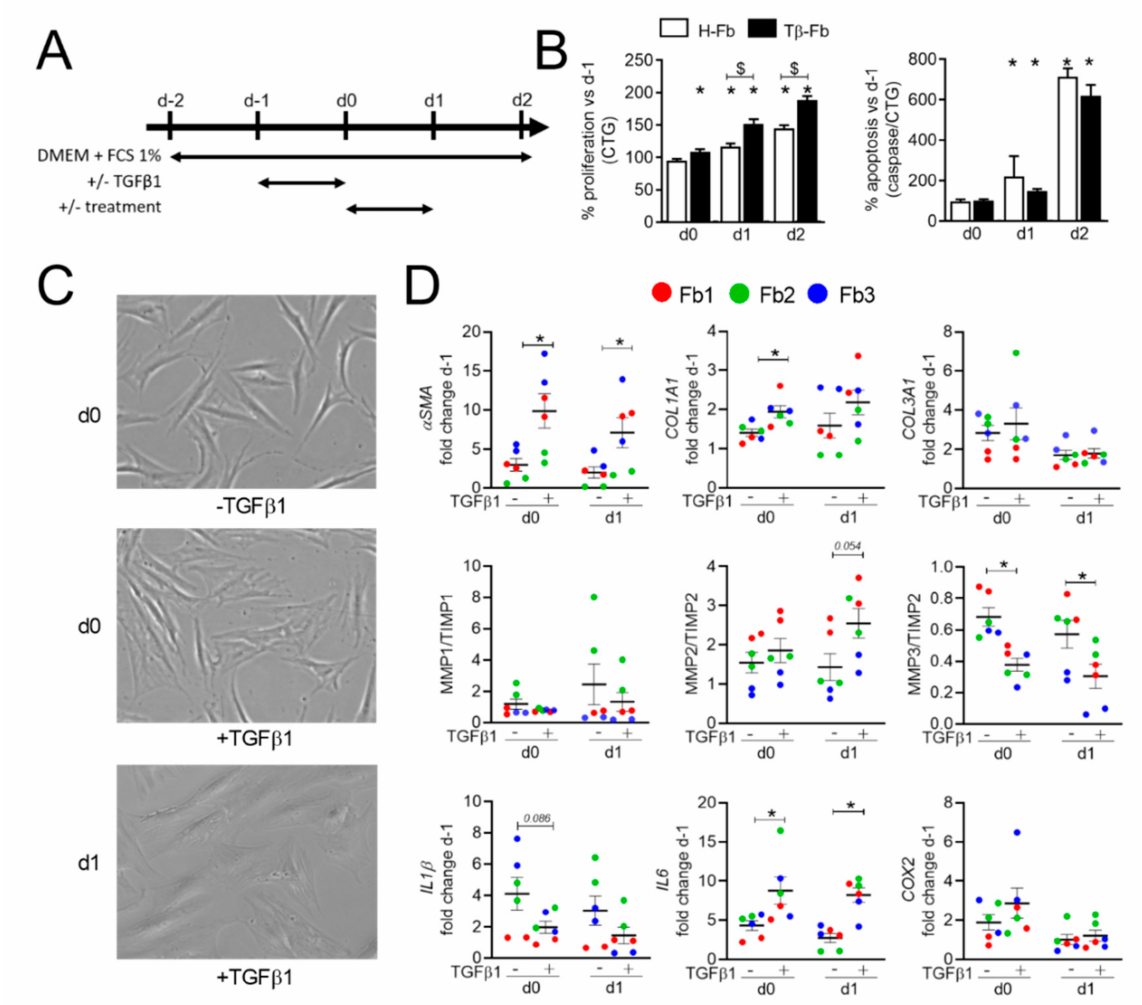
Figure 1. In vitro model of Transforming Growth Factor β 1 (TGF β 1)-stimulated fibroblasts. ( A ) Experimental scheme. Dermal fibroblasts from healthy donors (H-Fb) were starved in a DMEM medium containing 1% FCS (day-2) for 24 h before stimulation with TGF β 1 for 24 h. On day 0, treatment was applied for 24 h and samples were analyzed (day 1 or 2). ( B ) The proliferation of H-Fb or TGF β 1-stimulated fibroblasts (T β -Fb; left panel) normalized on day-1 ( n = 12). Apoptosis normalized on CTG assay (right panel). ( C ) Representative pictures of H-Fb ( − TGF β 1) on day 0 or T β -Fb (+TGF β 1) on days 0 and 1 after stimulation ( × 40 objective). ( D ) Fold change of gene expression normalized on day-1 ( n = 6). *: p < 0.05 versus H-Fb on day 0 or $: p < 0.05 versus the indicated